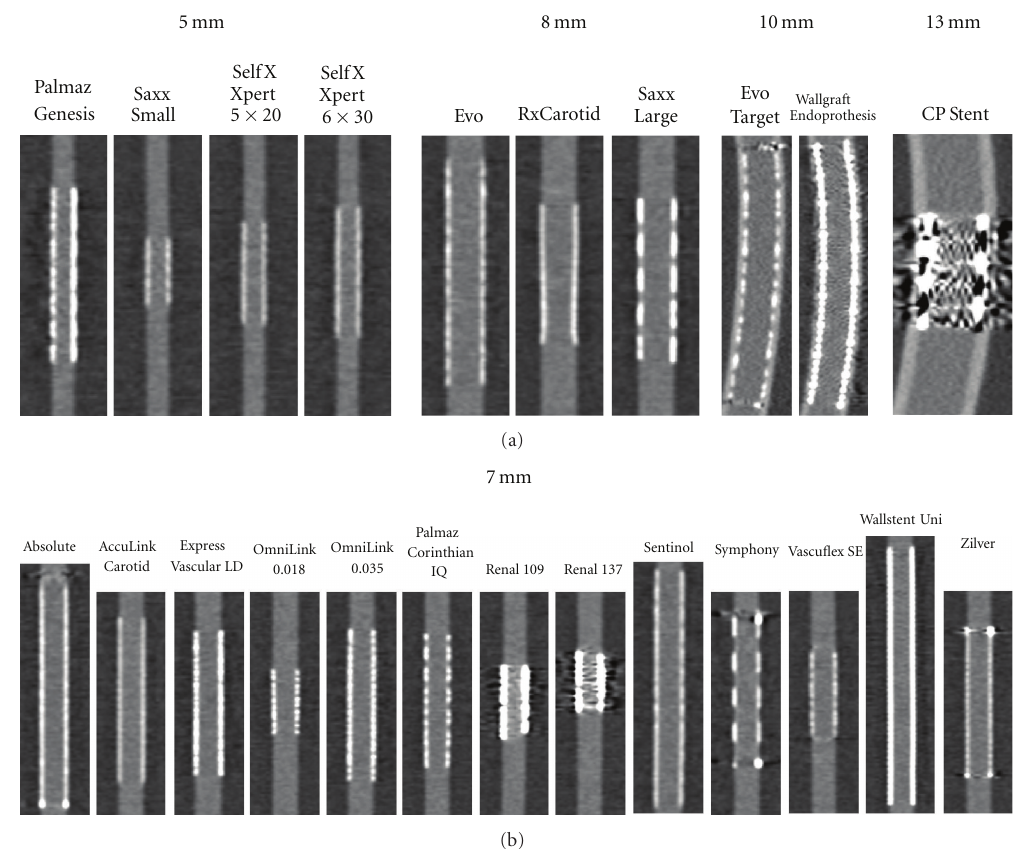
Figure 3: Comparison of 22 di ff erent peripheral arterial stents. Longitudinal through-plane reformations of 0.6mm slice thickness reconstructed using a B40f medium kernel are